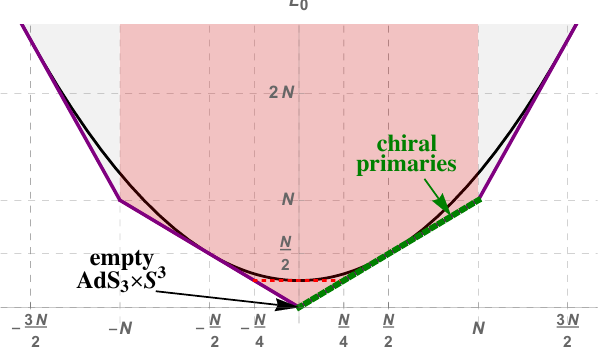
Figure 2 . The J - L 0 plane of the 3-charge system in the NS sector. The single-center BMPV black hole exists only above the black parabola L 0 = J 2 =N + N= 4 The empty AdS 3 (cid:2) S 3 correspond to the origin ( J; L 0 ) = (0 ; 0). Chiral primaries live on the green dotted line. in (cid:12)gure 1 are mapped into the NS sector in (cid:12)gure 2 where the J - L diagram is shown. 0 The empty AdS (cid:2) S 3 corresponds to the ground state at the origin ( J; L ) = (0 ; 0), while 0 3 2-charge states are chiral primaries on the line L = J (green dashed 0